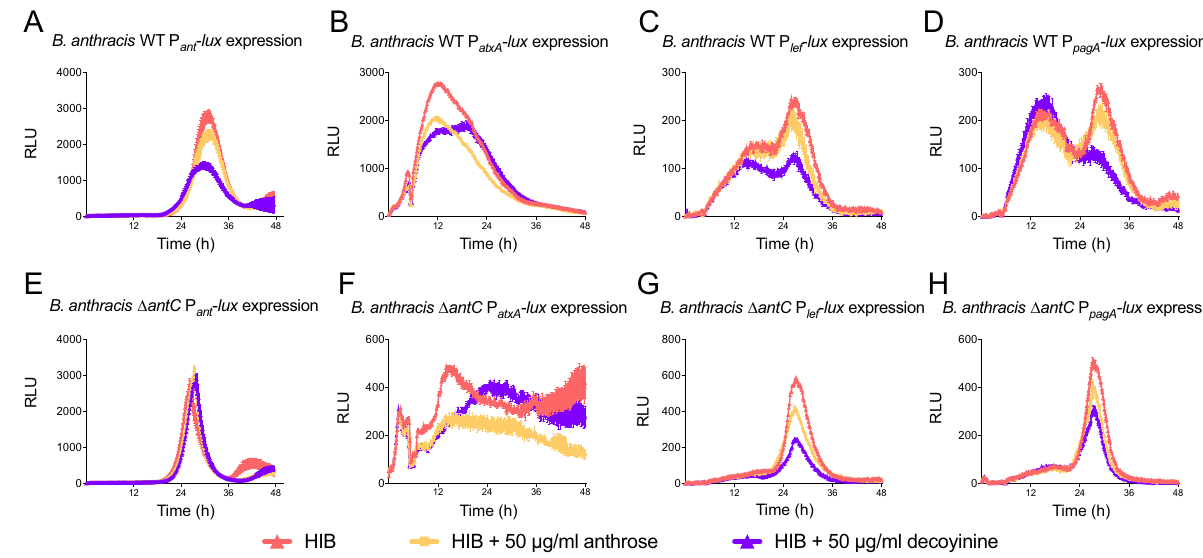
Figure 7. Anthrose and decoyinine have similar effects on expression profiles of toxin related genes. Luminescent expression patterns of ( A ) Sterne WT P ant - lux , ( B ) Sterne WT P atxA - lux , ( C ) Sterne WT P lef - lux, ( D ) Sterne WT P pagA - lux, ( E ) Sterne Δ antC P ant - lux, ( F ) Sterne Δ antC P atxA - lux, ( G ) Sterne Δ antC P lef - lux and ( H ) Sterne Δ antC P pagA - lux grown in HIB + Km 10 (red lines), HIB + Km10 + pure anthrose (orange lines), or HIB + Km10 + decoyinine (purple lines) show exogenous anthrose has similar impacts on gene expression as decoyinine in high protein, low sugar conditions; and mostly during stationary